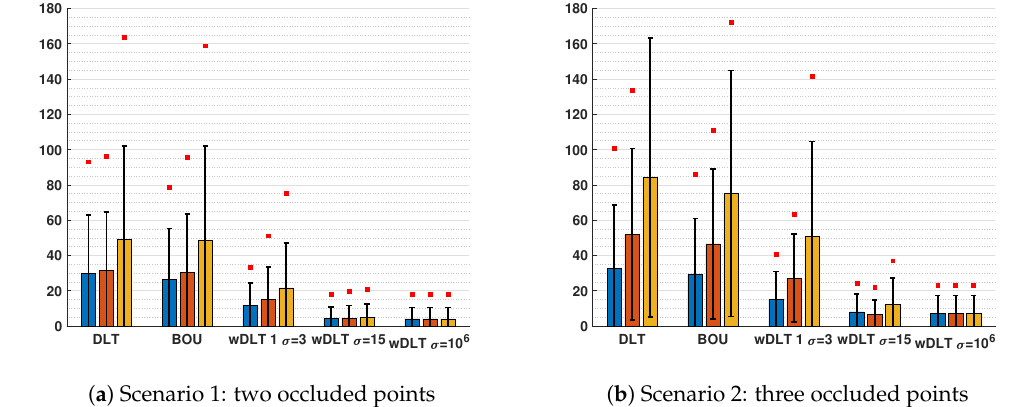
Figure 6. Reprojection error of the calibration with DLT, BOU, and wDLT with different settings of the uncertainty σ for points along the edges. The bars represent the average error, the black lines the average STD of the errors, and the red squares the average of the maximum